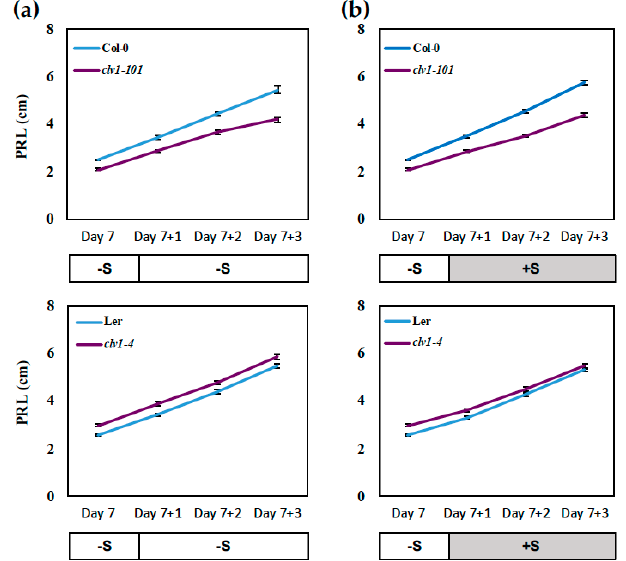
Figure 2. Effect of S supply on primary root growth. Wild-type (Col-0 and L er ) and clv1 mutant lines ( clv1-101 and clv1-4 ) were grown vertically on –S (15 µ M sulfate) medium for 7 days and then transferred to ( a ) –S medium or ( b ) + S medium to be grown subsequently for 3 days. Primary root length (PRL) was measured before (Day 7) and after the transfer (Day 7 + 1, 7 + 2, and 7 + 3) as indicated on each graph. Values show means ( ± SE) of 24 individual plants per treatment. White and dark grey bars labeled –S (15 µ M sulfate) and + S (1500 µ M sulfate) below the graph represent the S conditions before the transfer and during the